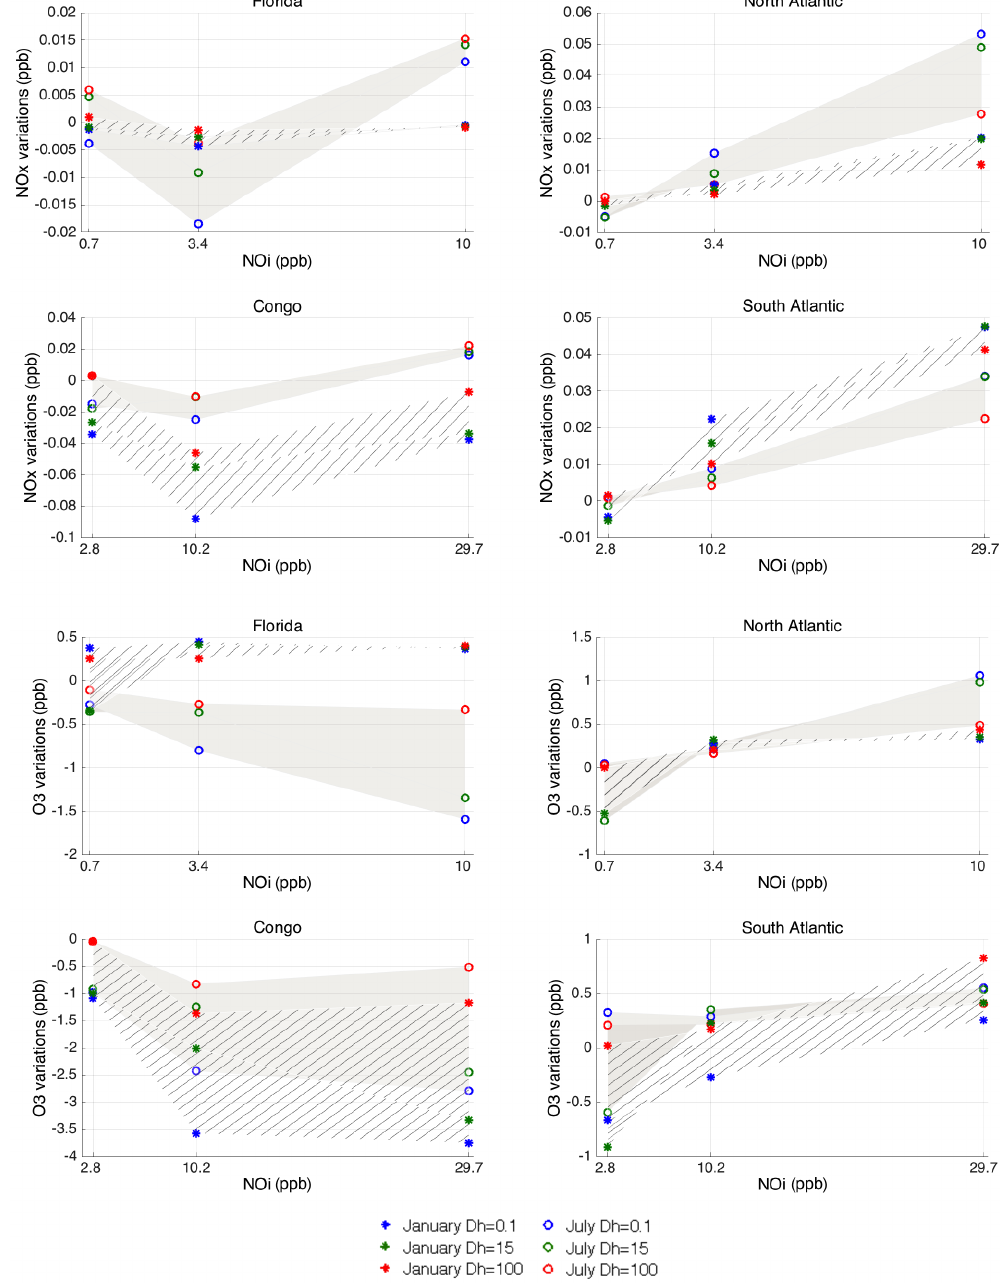
Figure 9. The NO x and O 3 sensitivity at 9km altitude depending on the horizontal coefficient diffusion ( D h , m 2 s − 1 ) and on the NO mixing ratio injected by lightning (NO i , ppb) for the midlatitudes (Florida and North Atlantic) and the tropics (Congo Basin and South Atlantic). Intervals are hatched in January and filled in grey in July. Markers correspond to the NO x variations simulated for D h = 0 . 1m 2 s − 1 (red), D h = 15m 2 s − 1 (blue), and D h = 100m 2 s − 1